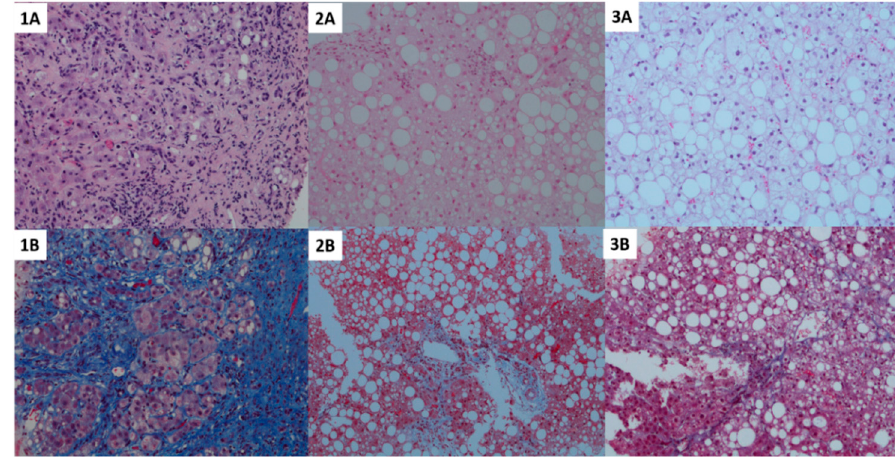
Figure 1. Histological pictures indicative of the statistical results including hematoxylin and eosin staining (top row) and CAB staining for fibrosis (bottom row) of the 3 groups stratified by BMI. Panel 1A and 1B —lean; 2A and 2B —overweight; 3A and 3B —obese group. A higher degree of fibrosis with together with a lower degree of steatosis was observed in lean subjects (left, 1A and 1B ), while more fat accumulation but lower fibrosis and disease activity was observed in overweight subjects (middle, 2A and 2B ). Obese subjects presented with the highest degree of fibrosis and a fibrosis and NASH similar to lean subjects (right, 3A and 3B ).